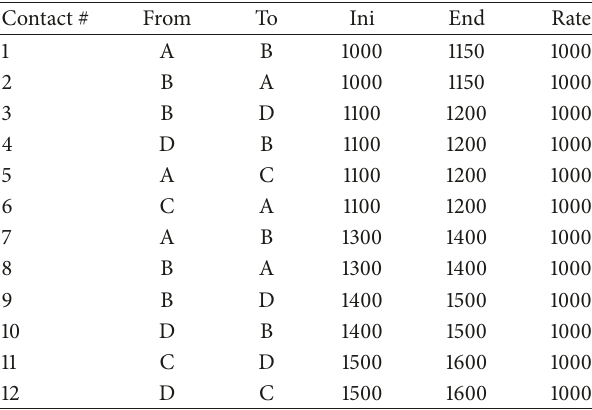
Table 1: IP and DTN protocols comparison. Table 2: Contact plan